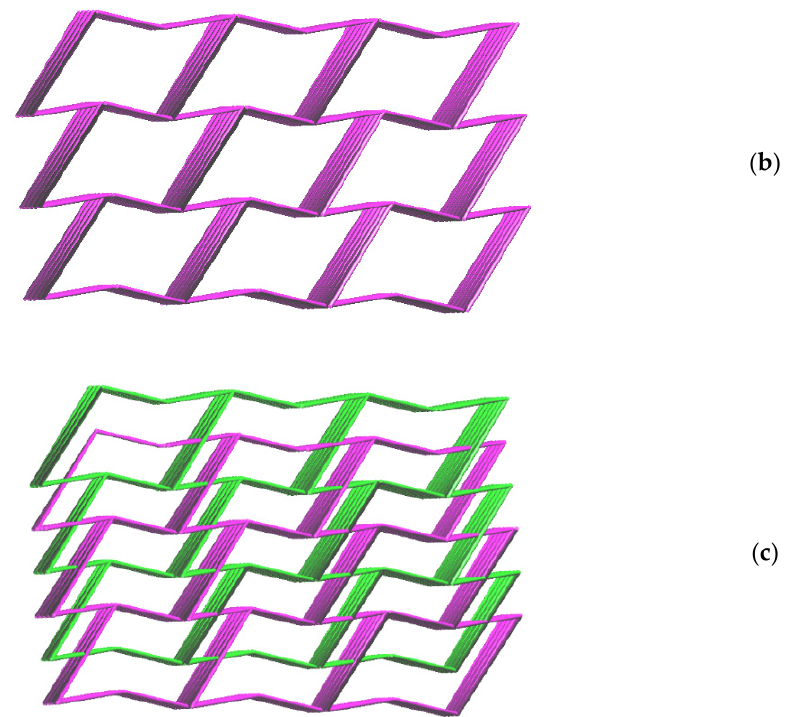
Figure 5. ( a ) Coordination environment of Ni(II) ion in 5 and 6 . Symmetry transformations used to generate equivalent atoms: (A) − x + 2, − y + 2, − z − 1; (B) − x + 1, − y + 1, -z for 5 and (A) − x + 1, − y, − z + 1; (B) − x + 2, − y + 1, − z for 6 . ( b ) A drawing showing the dia topology. ( c ) A drawing showing the 2-fold interpenetration.